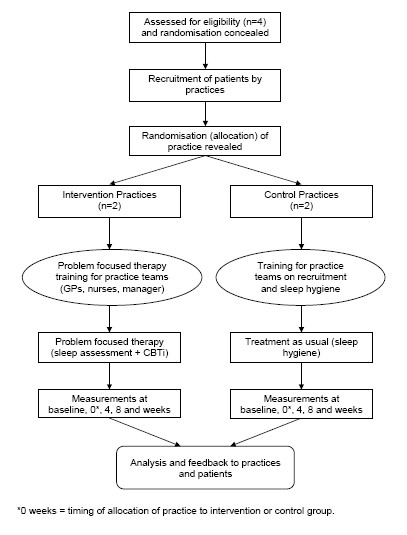
Consort diagram.